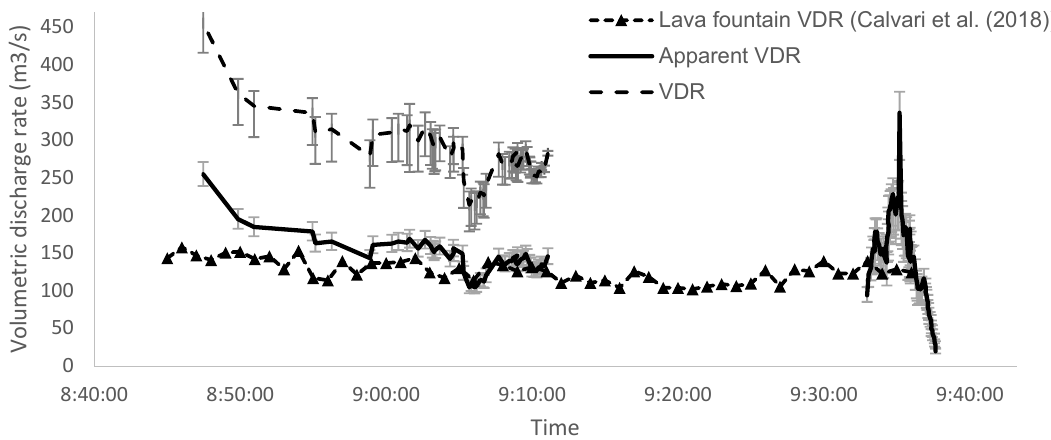
Figure 10. Comparison between cloud volumetric discharge rate (VDR) estimated from H (plume) using Equation (10) from Woodhouse et al. (2013) [60] and measurements of Calvari et al. (2018) [28].